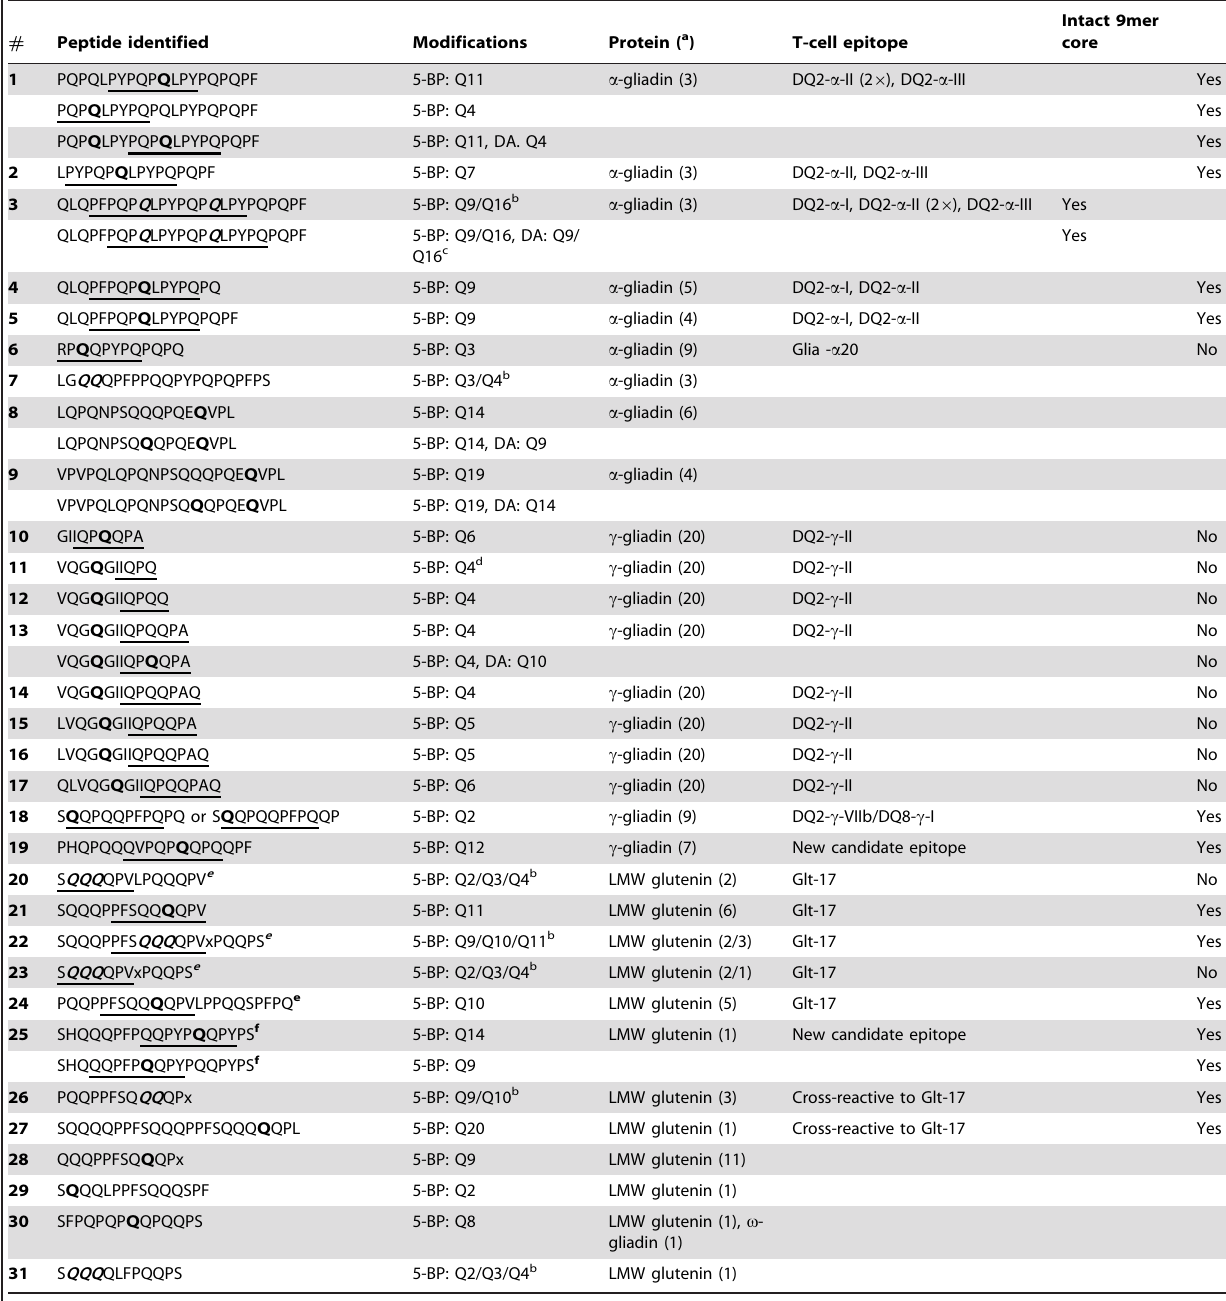
Table 2. TG2 peptide substrates identified by nano-LC